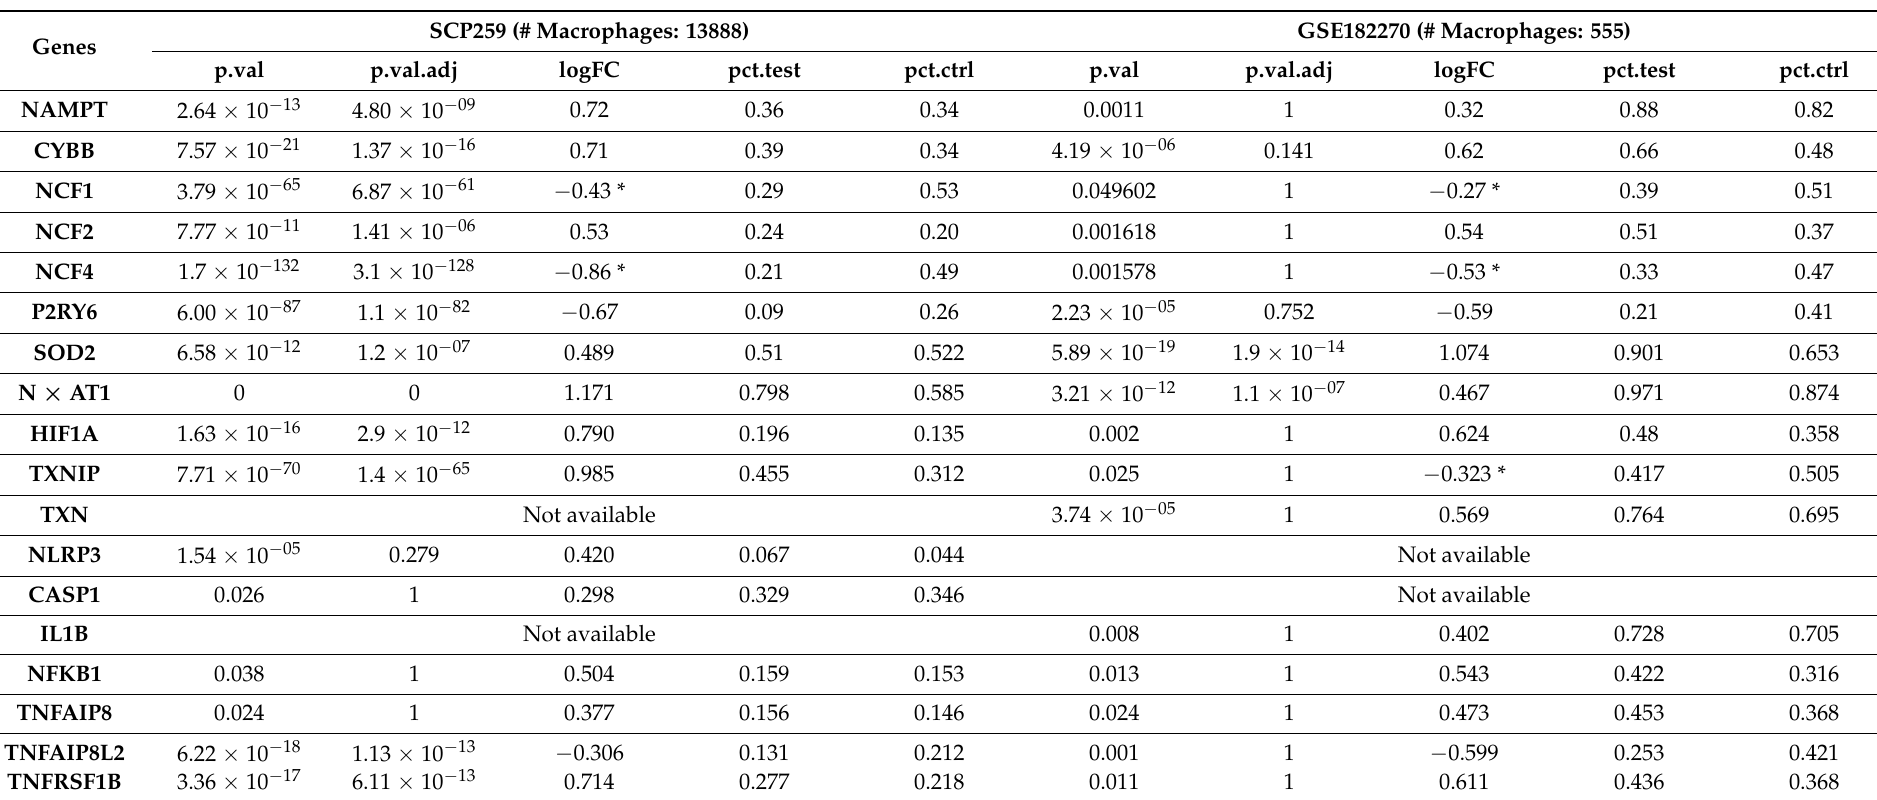
Table 2. Macrophage DEG analysis result summary for the genes involved in the NLRP3 inflammasome activation via the redox signaling